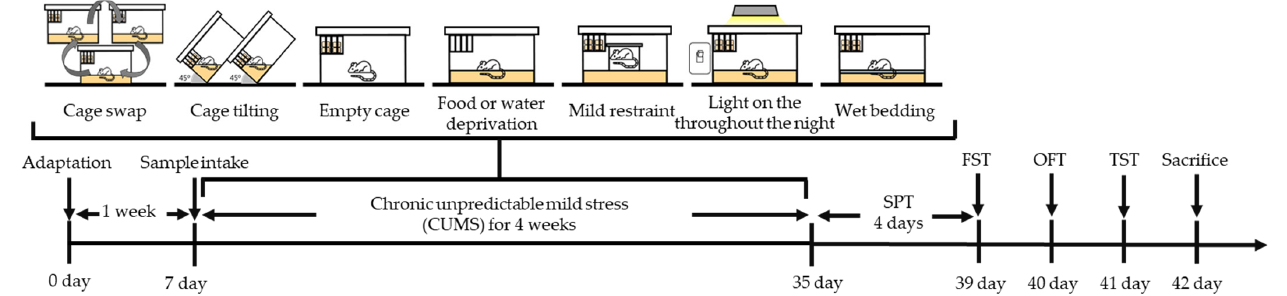
Figure 1. Schematic experimental design in the chronic unpredictable mild stress (CUMS)-induced